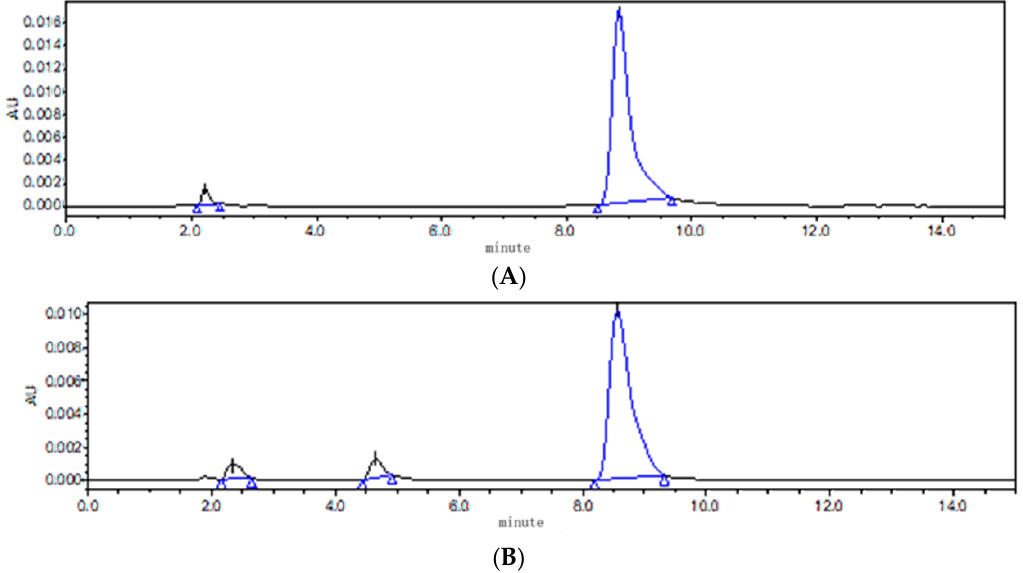
Figure 4. The chromatogram of ABZ ( A ) and ABZ ( B ) under high temperature of 90 °C.